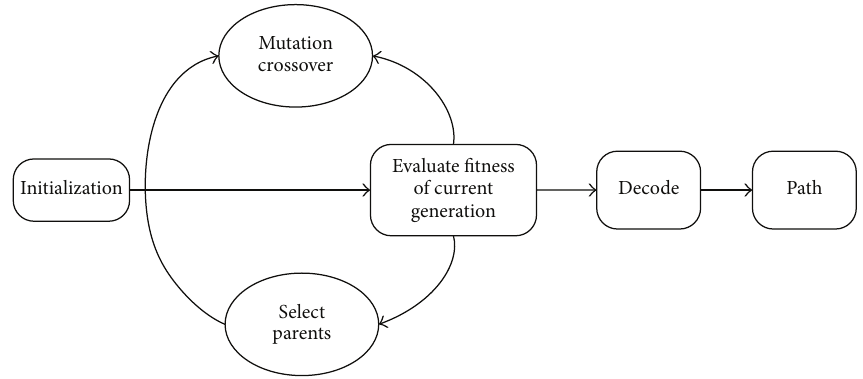
Figure 12: Evolution process for path